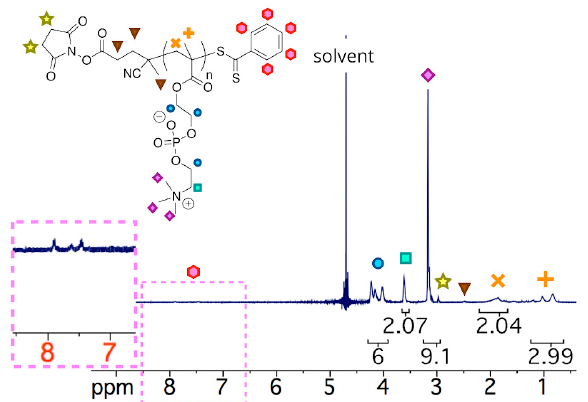
Figure 2. Representative 1 H NMR of purified poly(2-methacryloyloxyethyl phosphorylcholine methacrylate) (PMPC) in D 2 O. Symbols above NMR signals correspond to the labeled atoms on the chemical structure.